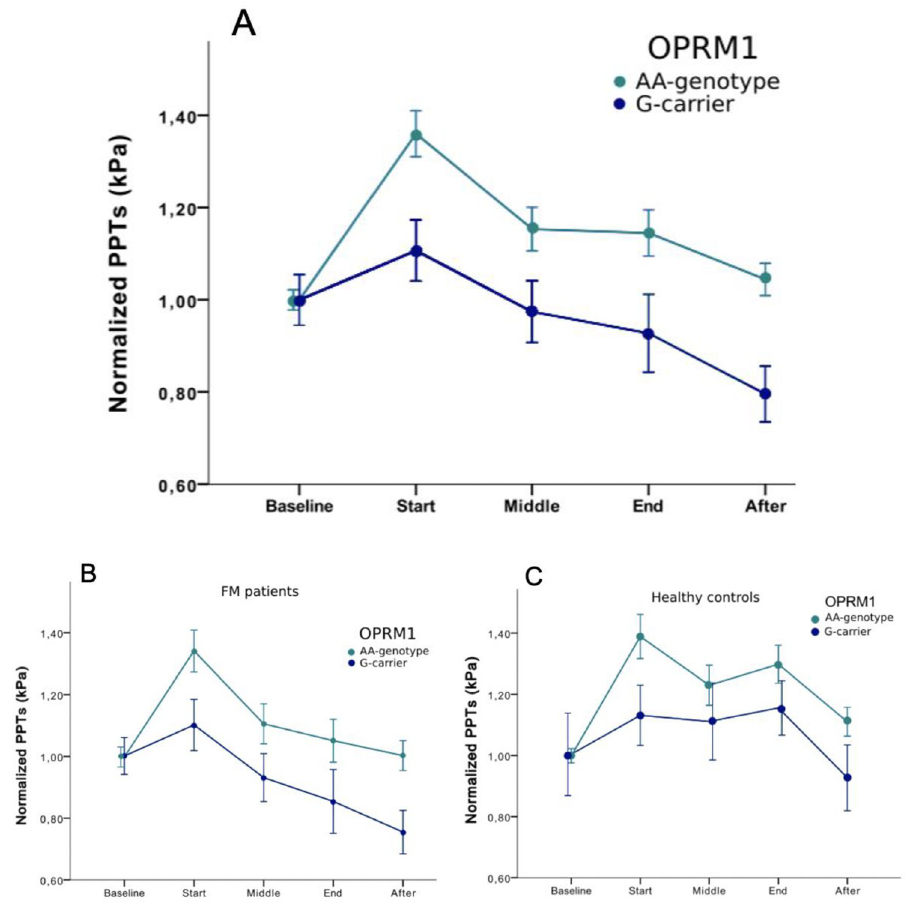
Fig 4. A. Normalized pressure pain thresholds (PPTs) (mean +/- SEM) at baseline, start, middle, end and 5 minutes after a standardized assessment for conditioned pain modulation for the whole group divided into OPRM1 AA versus G-genotypes. Individuals with OPRM1 G-genotype had significantly reduced PPTs at start (p = 0.035) and after (p = 0.008). 4B and 4C. The effect of OPRM1 normalized PPTs over time in fibromyalgia (FM) patients and healthy controls analyzed separately. No significant GENOTYPE x GROUP interaction was found, indicating similar effects in both groups regardless of baseline pain